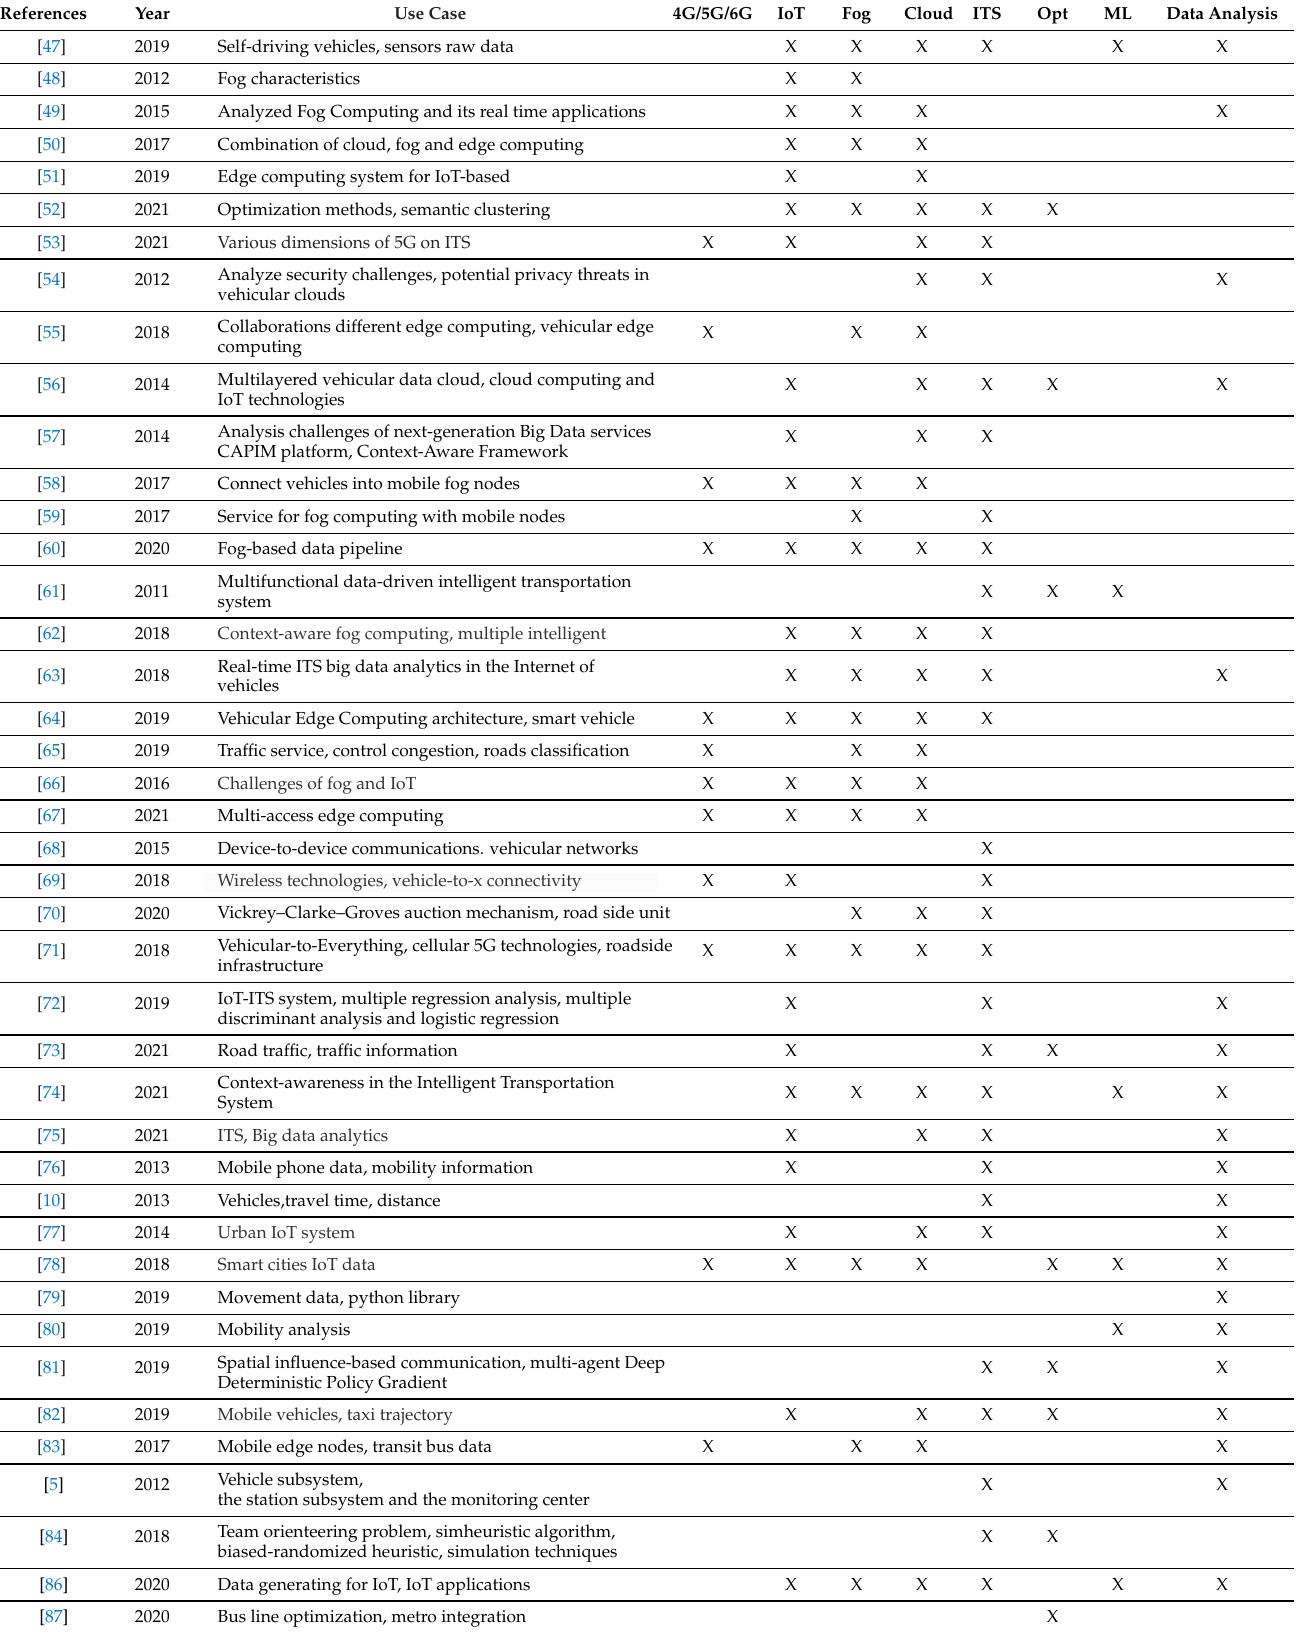
Table 4. Comparison of the reviewed